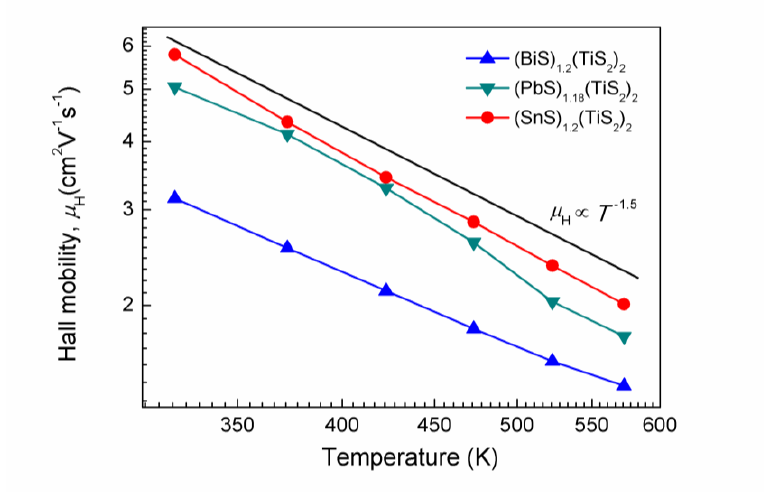
Figure 5. Hall mobilities for (BiS) 1.2 (TiS 2 ) 2 , (SnS) 1.2 (TiS 2 ) 2 and (PbS) 1.18 (TiS 2 ) 2